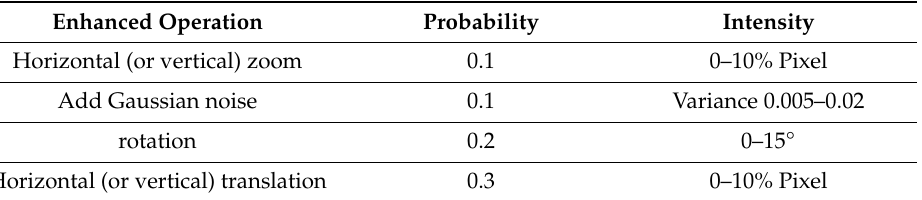
Table 2. Second stage augmentation